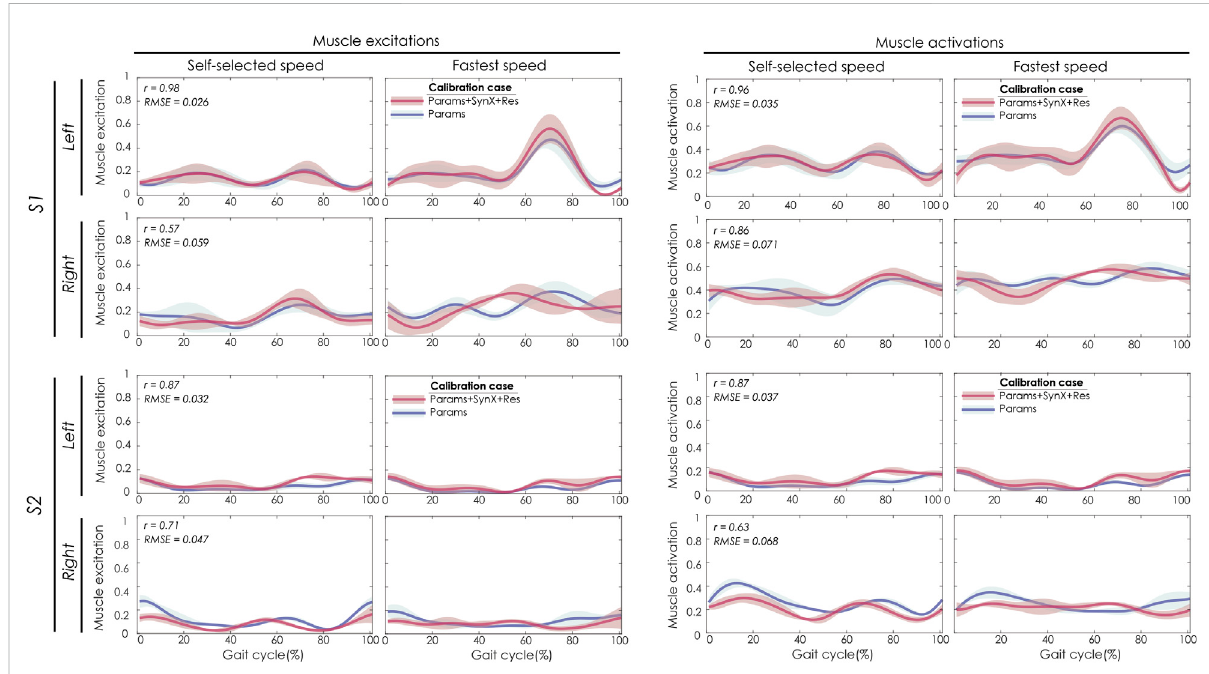
FIGURE 8 SynX-predicted muscle excitations and activations for psoas constructed with the best methodological combinations for the “ validation ” situations (speed-speci fi c unmeasured and speed-speci fi c residual synergy vector weights with six synergies). Lines represent mean curves across calibration trials, and shaded areas represent ±1 standard deviation. r and RMSE values for muscle excitations and activations were calculated between “ Params+ SynX +Res ” calibration(in pink)and “ Params ” calibration(in blue). “ Params ” calibrationwasperformedusing acompleteset ofEMGsignals, wherenomuscleexcitationswerepredicted.Dataarereportedforthecompletegaitcycle,where0%indicatesinitialheel-strikeand 100% indicates subsequent heel-strike for each leg of both subjects (right leg: paretic, left leg: nonparetic). SynX-predicted muscle excitations and activations for iliacus were of similar accuracy (not shown).